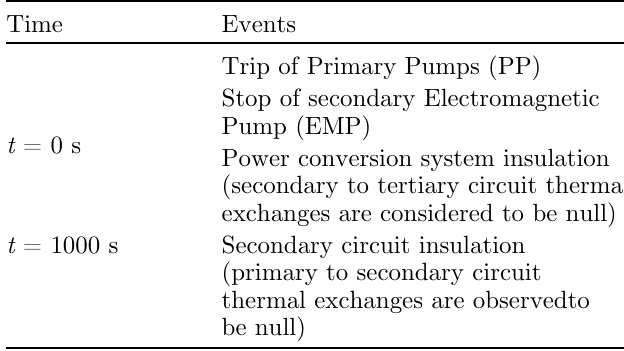
Table 3. USBO events